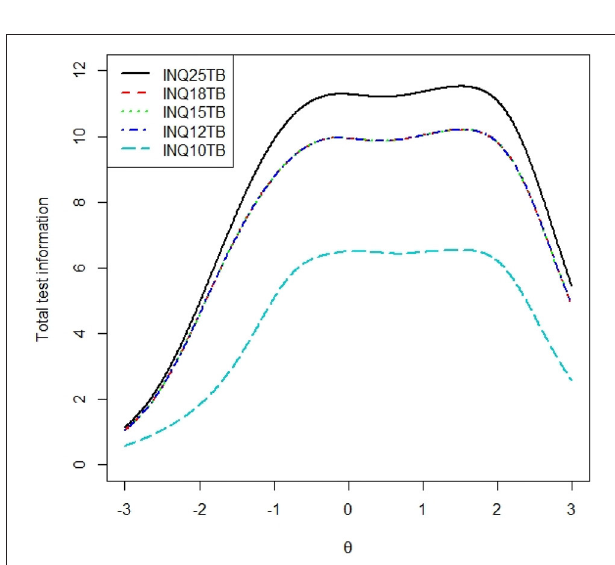
FIGURE 2 | Total test information curves of thwarted belongingness of each version. INQ25TB=thwarted belongingness subscale of INQ-25; INQ18TB=thwarted belongingness subscale of INQ-18; INQ15TB=thwarted belongingness subscale of INQ-15; INQ12TB=thwarted belongingness subscale of INQ-12; INQ10TB=thwarted belongingness subscale of INQ-10, same as below.